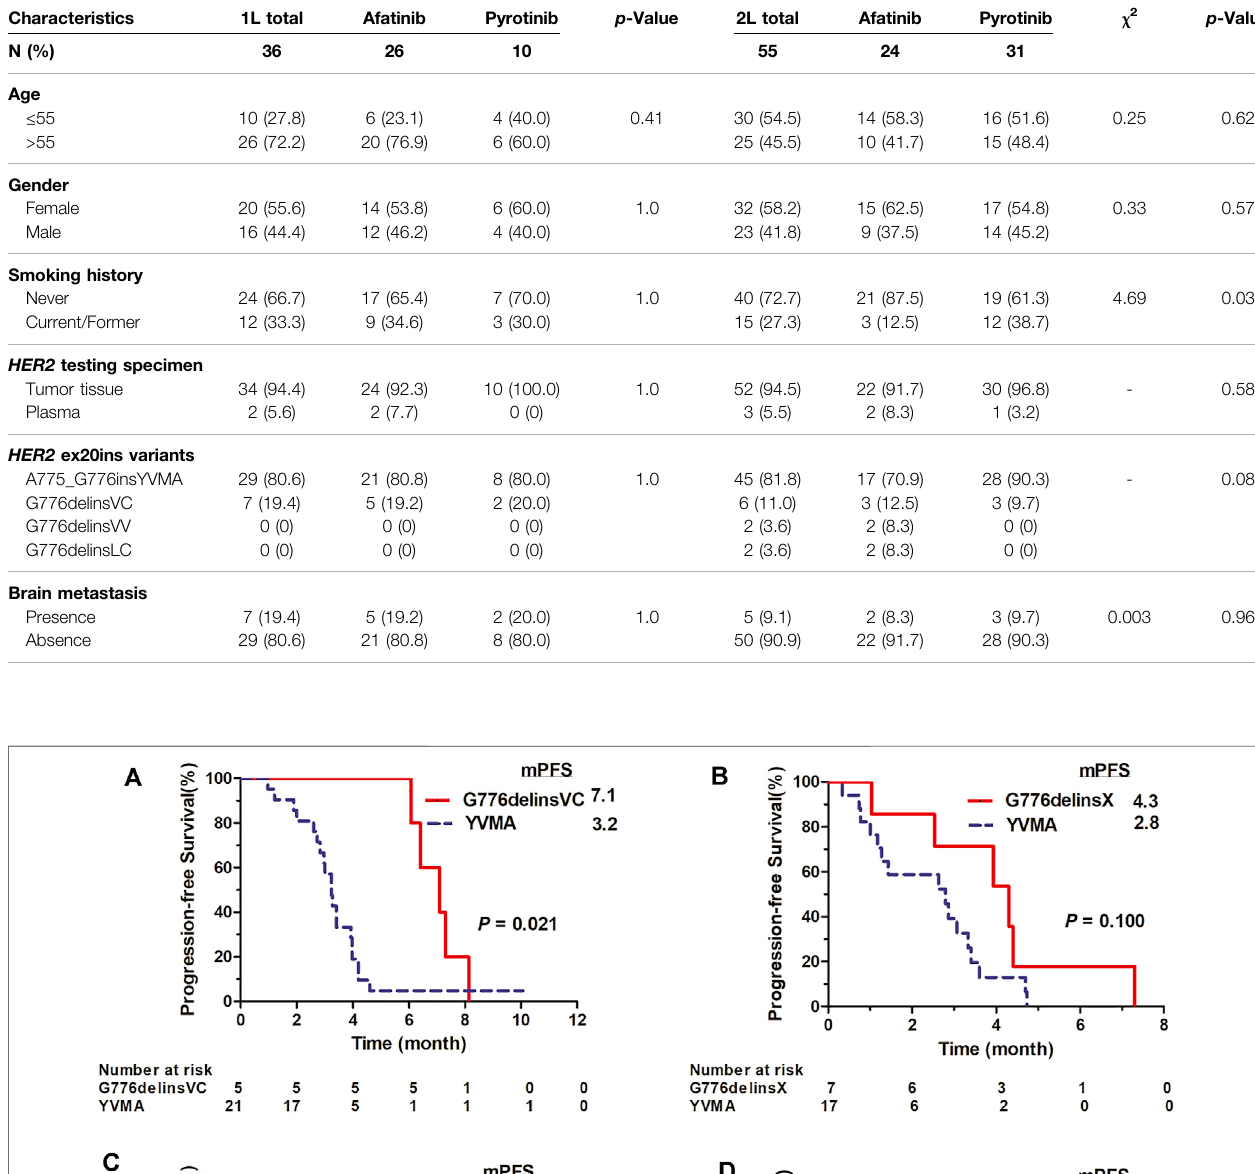
TABLE 1 | Clinicopathological characteristics of patients with HER2 ex20ins by 1L and 2L targeted therapies.